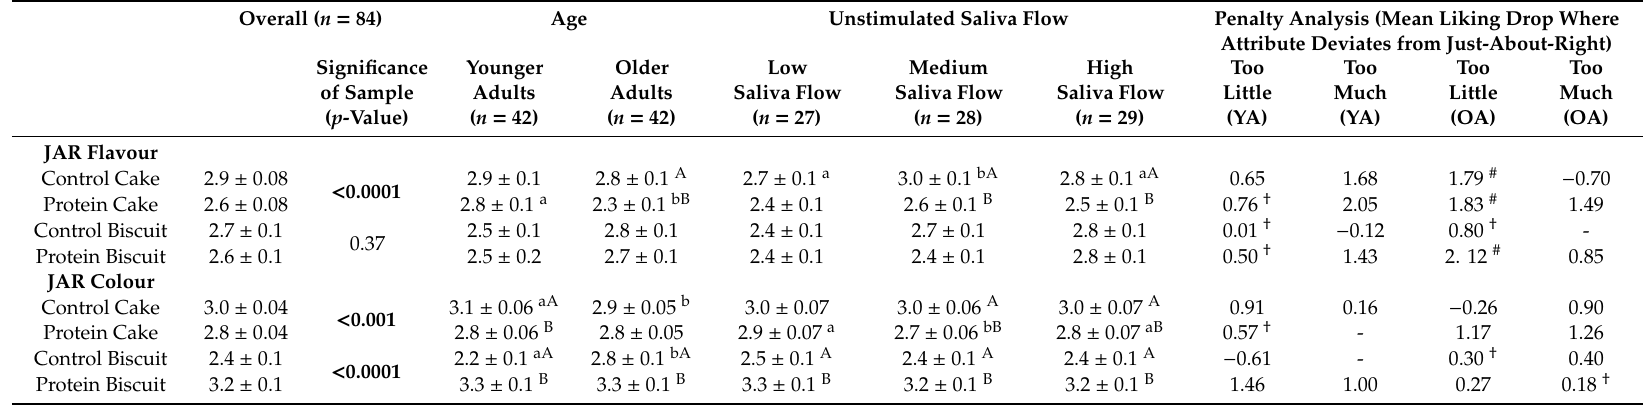
Values are expressed as LSM estimates ± standard error from SAS output. Significant di ff erences ( p < 0.05) within a row (i.e., age YA vs. OA and saliva flow pairwise comparisons) are denoted by di ff ering small letters, and within a column (i.e., within an age group between samples or within saliva flow groupings between samples) are denoted by di ff ering capital letters. In penalty analysis # represents a significant di ff erence ( p < 0.05) between penalty analysis groups within a sample for older adults, † represents where the size of the group is lower than 20% of the population, and - represents where 0% of the population selected the category. Individual saliva flow groupings are derived from unstimulated saliva flow only, through tertile